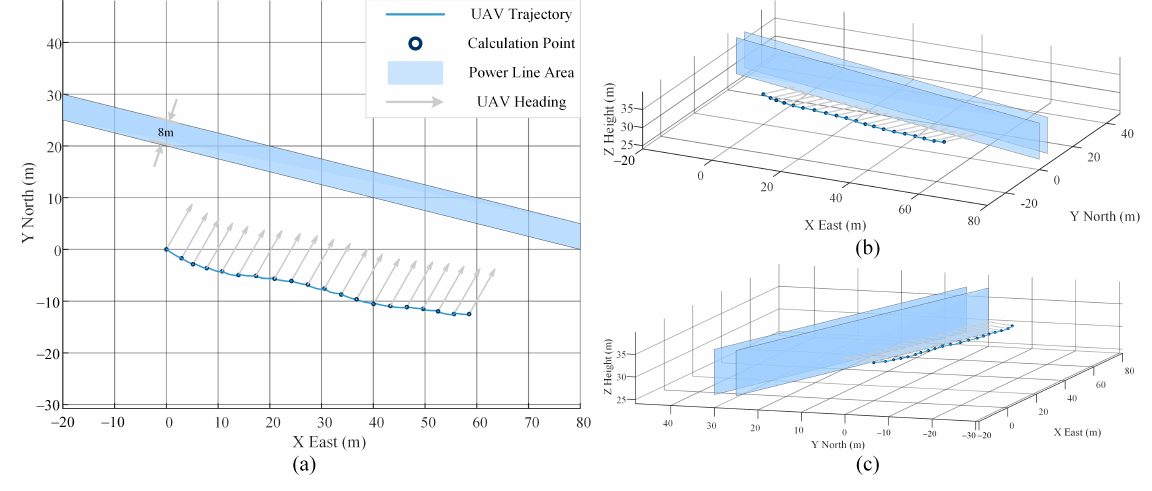
Figure 13. The detailed trajectory of a flight. ( a ) Altitude view; ( b , c ) are different planar views.